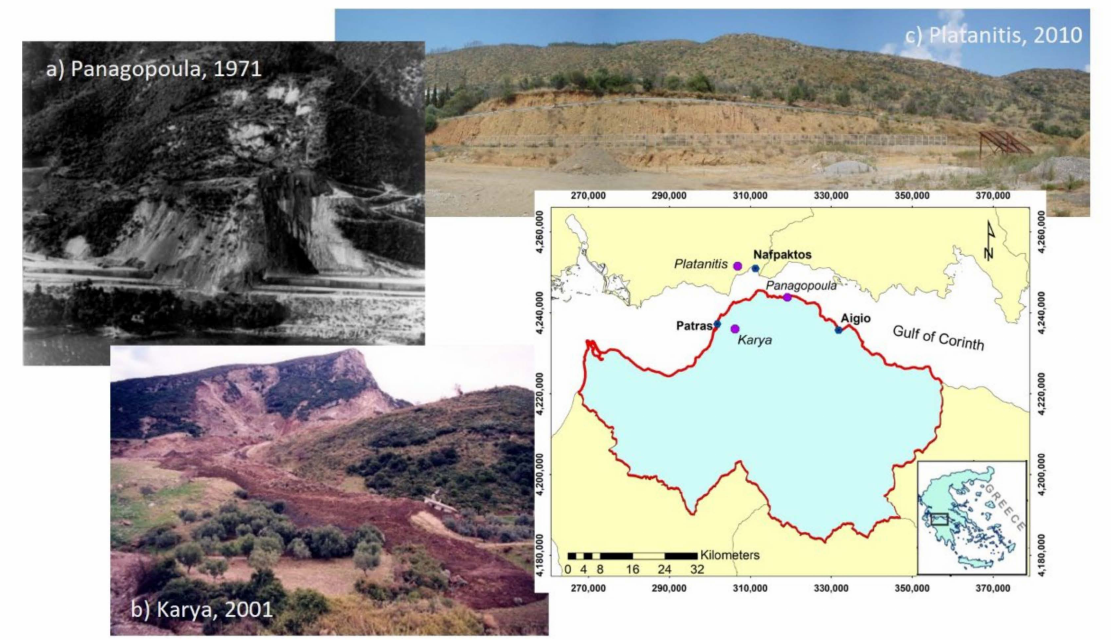
Figure 1. Location map and views of the main landslide event in ( a ) Panagopoula, 1971, ( b ) Karya, 2001, and ( c ) Platanitis, 2010. The map margins correspond to the Hellenic Geodetic Reference System of